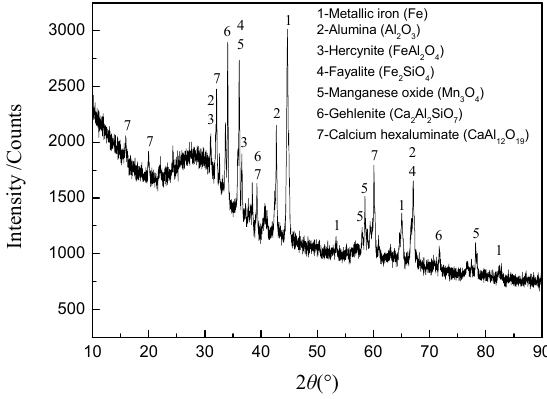
Figure 14. The XRD pattern of the alumina slag.